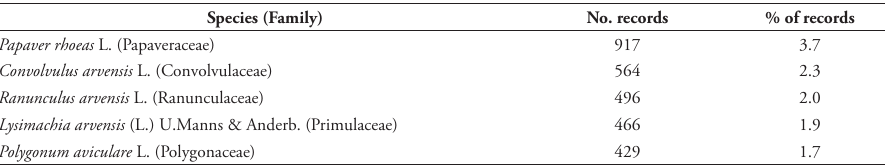
Table 3. The five most represented species in the “Segetal flora of Italy” dataset: family, number of records and percentage of records are reported for each